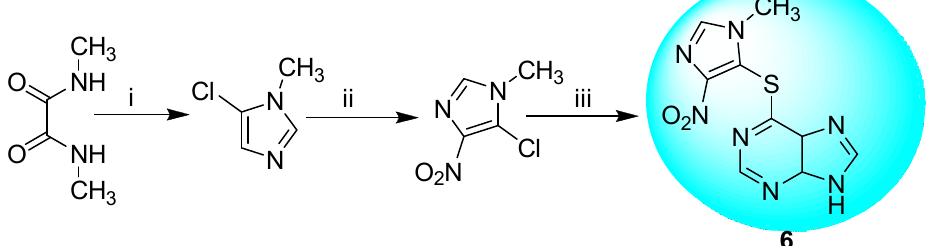
Figure 9. Activity profile of Azathioprine 6 [85].